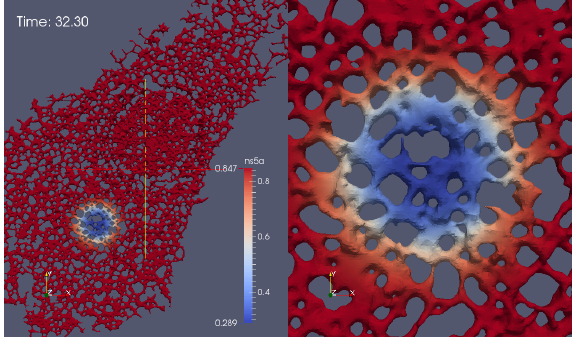
Figure A6. Screenshot of NS5A FRAP experiment simulation on ER surface, Geometry IV (suppl. movie, “S2 Video in supplementary